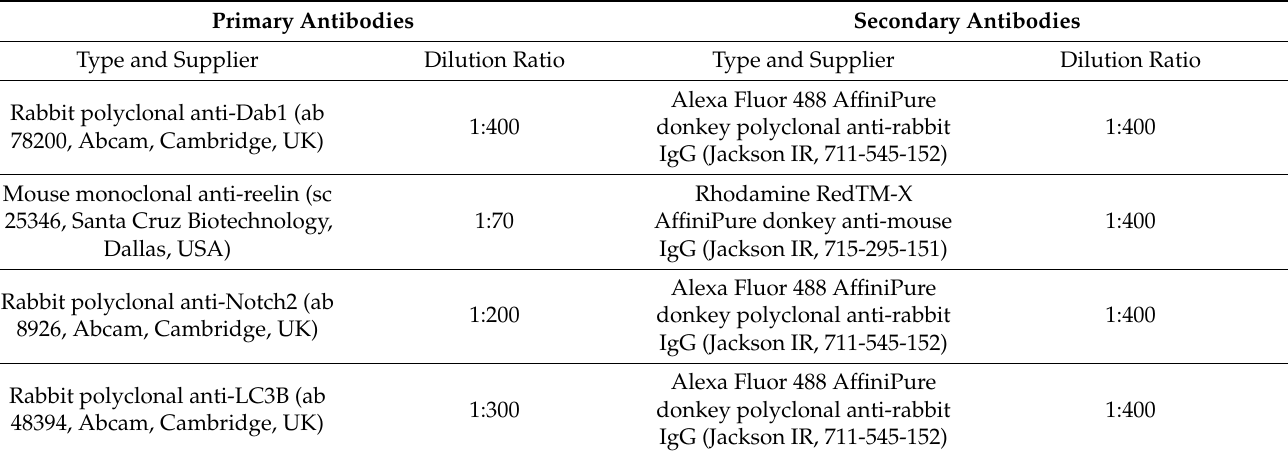
Table 1. Antibodies used for